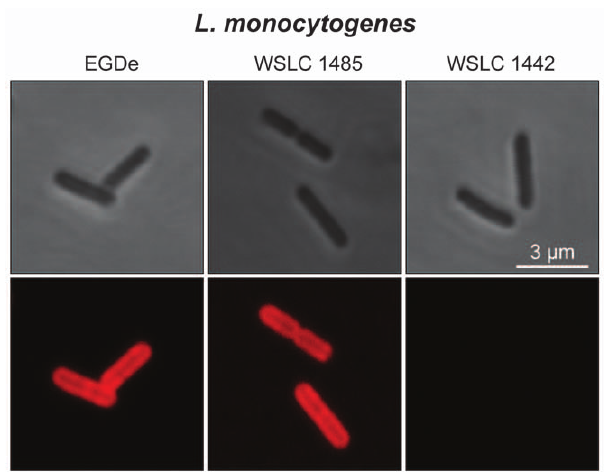
Figure 3. Binding of wheat germ agglutinin (WGA) to Listeria cells wall. Listeria cells of strain EGDe (left), WSLC 1485 (middle) and WSLC 1442 (right) were labeled with WGA-Alexa Fluor H 594 conjugate. WGA specifically recognizes GlcNAc residues in WTAs. Top: phase contrast images. Bottom: corresponding fluorescence microscopy (confocal)